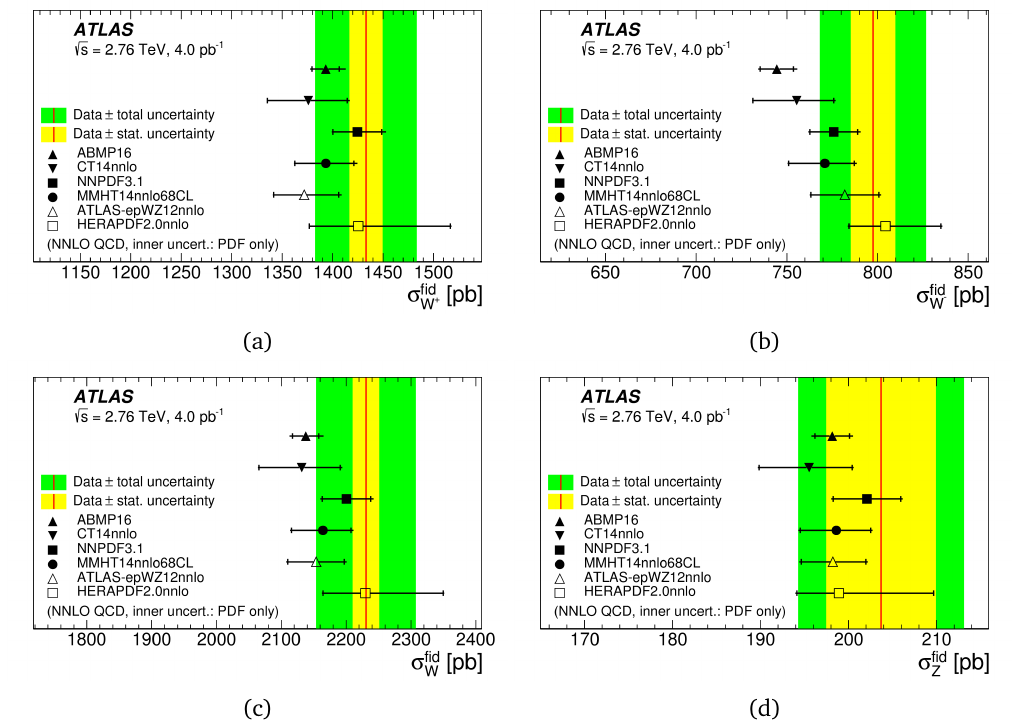
Figure 1: NNLO predictions for the fiducial cross-section compared with the mea- sured cross-section of (a) W + , (b) W − , (c) W ± combined and (d) Z. Plots are taken from [ 2 ]